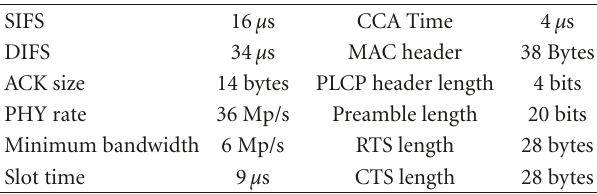
Table 4: The PHY and MAC layer